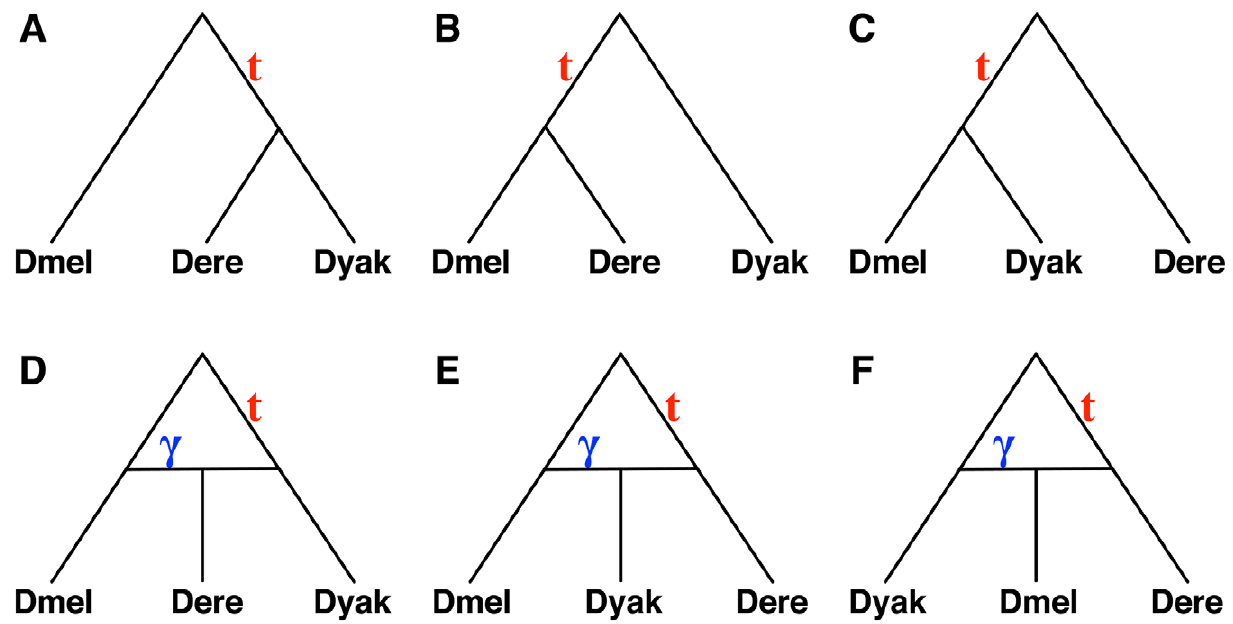
Figure 3. Six hypotheses for the evolutionary history of a Drosophila data set. (A–C) The three possible species tree topologies. (D–E) The three possible single-hybridization species network topologies (excluding extinction events).